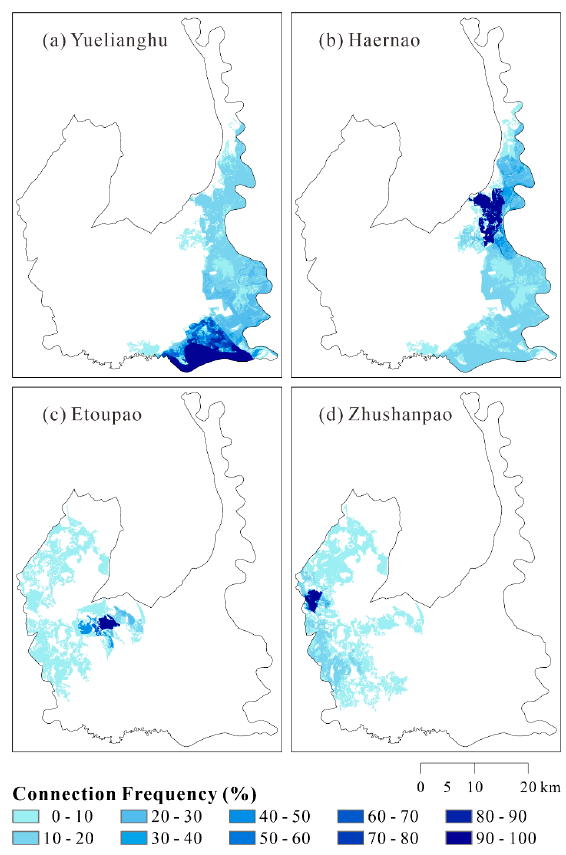
Figure 16. Connection frequency of the the four main connectomes (i.e., seasonally connected water bodies) in the Momoge National Nature Reserve, China from 2015 to 2019. ( a ), Yuelianghu ( b ), Haernao ( c ), Etoupao and ( d ) Zhushanpao.